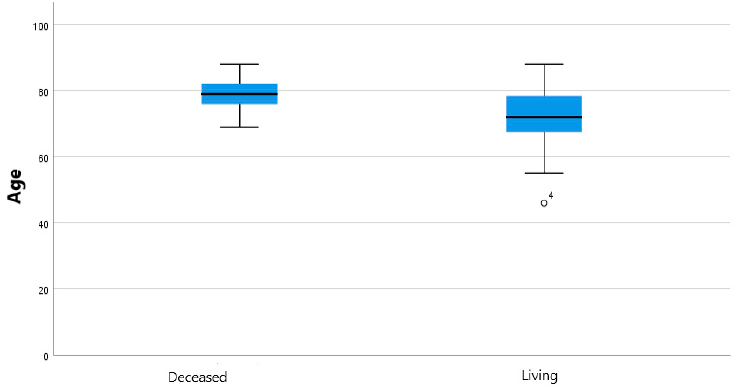
Figure 4. Boxplot showing relationship of mortality of patients by age. Outliers are marked with a circle and the case number.